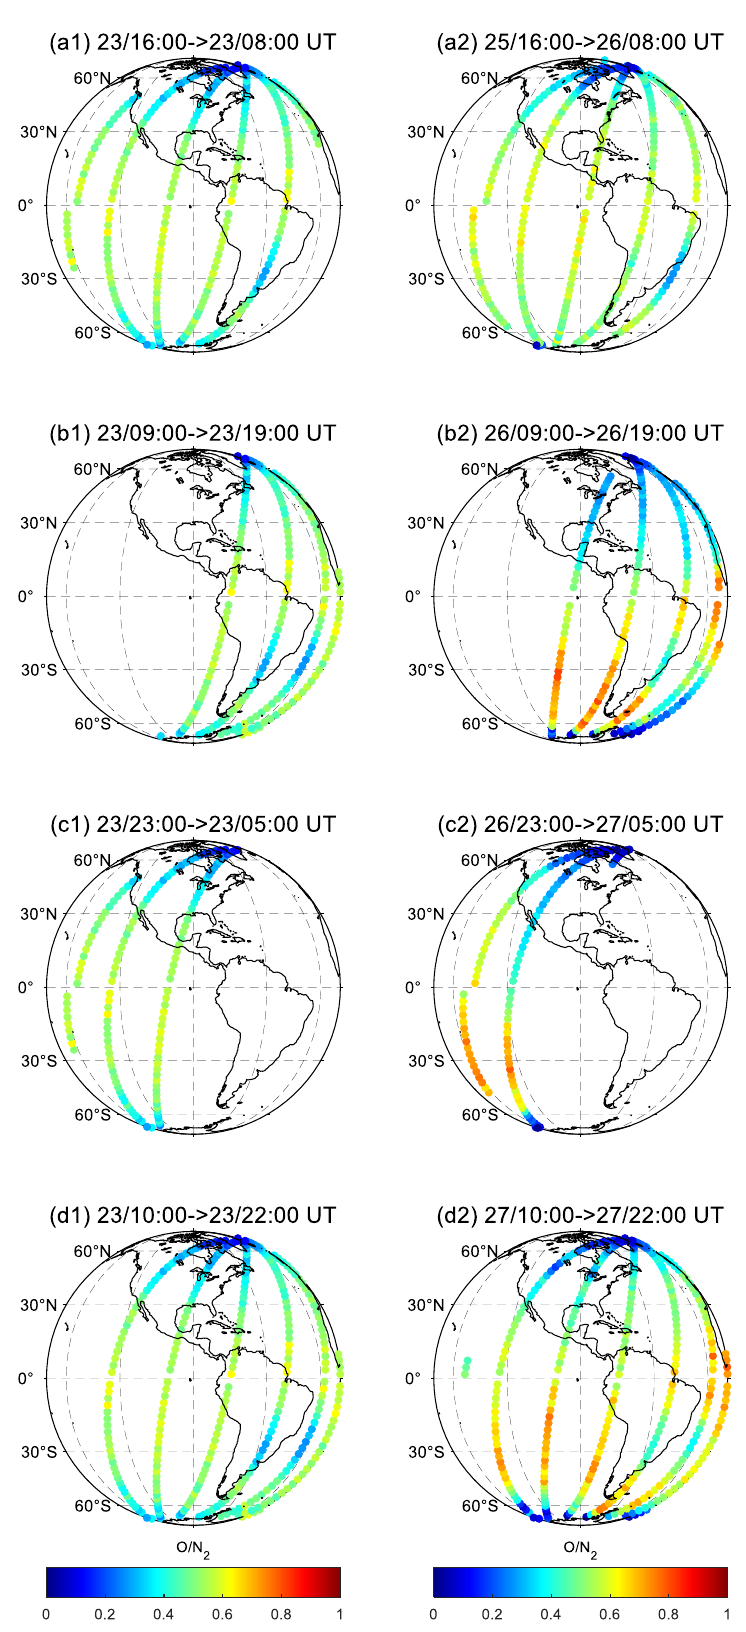
Figure 11. Comparison of ∑ O/N 2 ratio from GUVI between quiet day ( left column) and storm days ( right column).